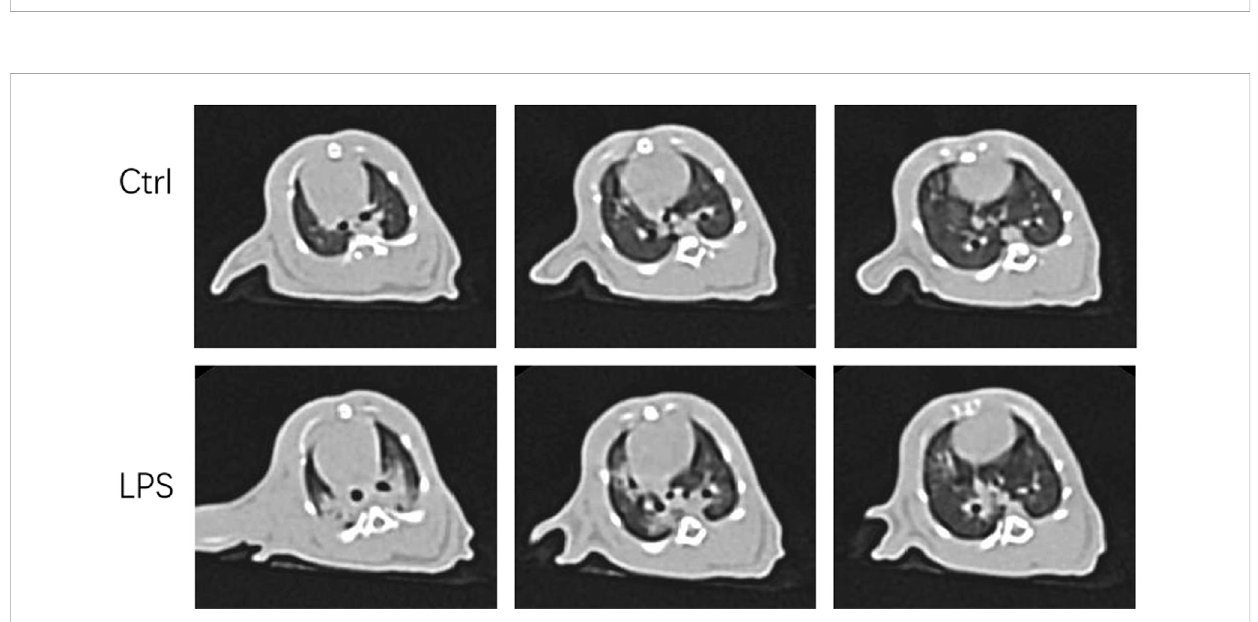
FIGURE 2 Computer tomography images of LPS-induced ARDS rats and controls. Chest computed tomography was performed in rats induced by LPS or saline (control). Images demonstrate one representative animal per group and were viewed at the same window width (2000 HU) and window level ( − 500